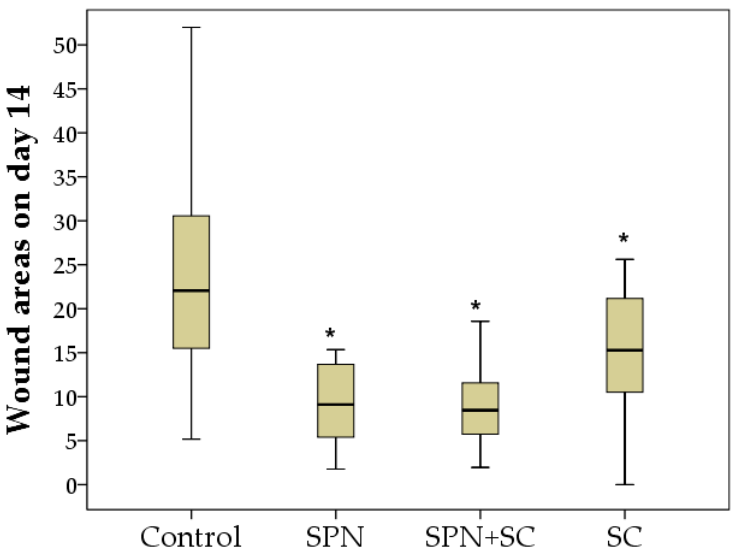
Figure 6. Wound areas on day 14 of the study in different groups (mm 2 ). Notes: *—difference from the control group at p < 0.05. Post hoc analysis score (Dunnett’s t -test for comparison with a control group). Data are presented as median and interquartile range.